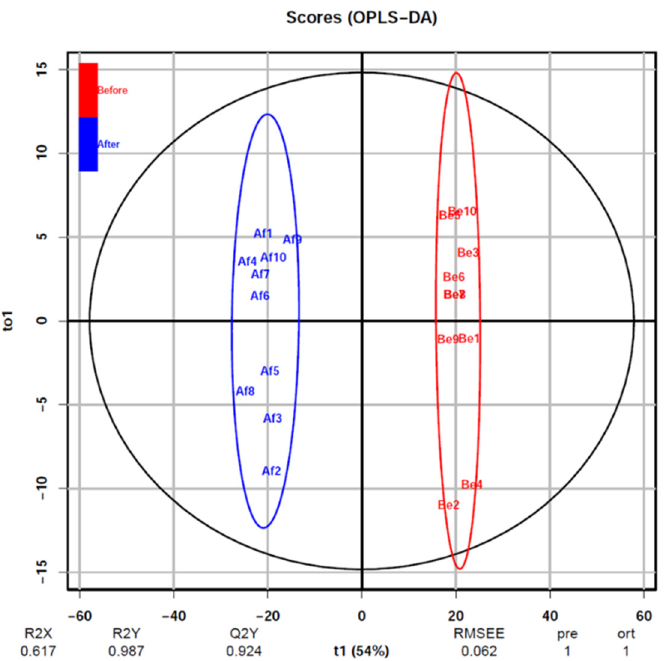
Figure 4. OPLS-DA plot for proteomics datasets of urine samples collected before the combined simulated firefighting test and after this.